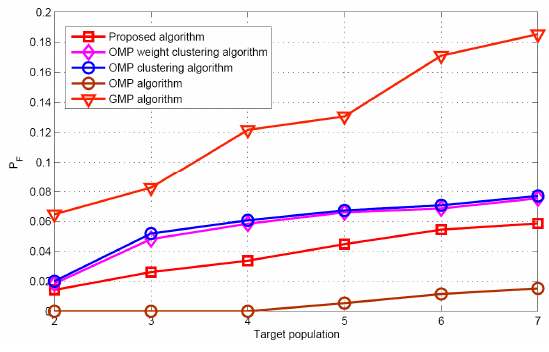
Figure 8. False alarm rate versus target population.